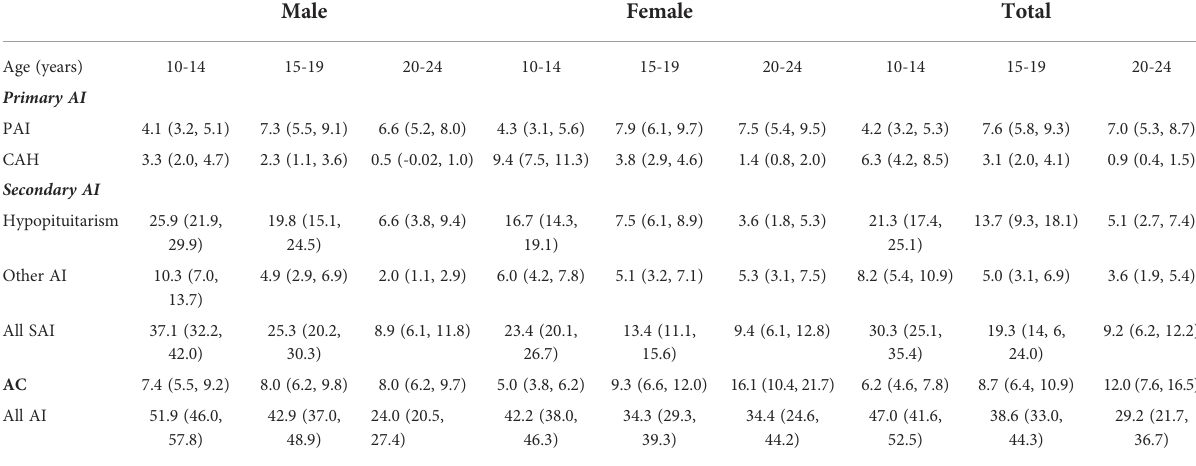
TABLE 1 Average admission rates by sex and age group and adrenal Insuf fi ciency Subtype*.